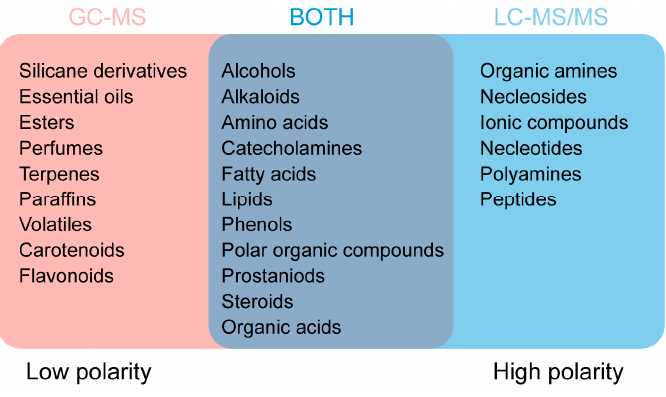
Figure 1. Compounds that can be identified using GC-MS and LC-MS/MS.